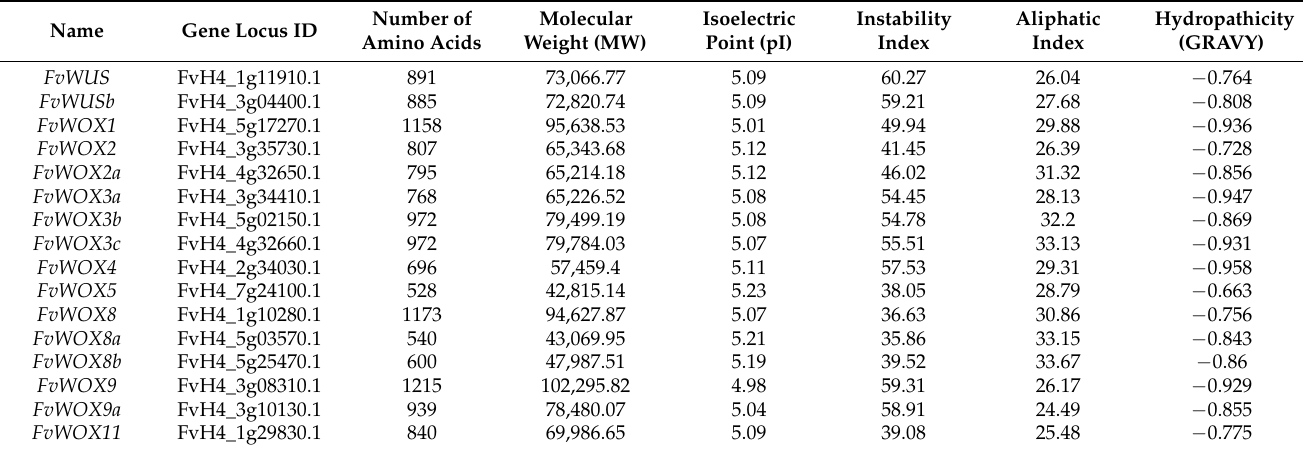
Figure 1. Chromosome localization map of FvWOXs. Yellow vertical bars with various lengths represent the woodland strawberry chromosomes. Short black horizontal lines indicate the position of each FvWOX. Table 1. Summary information of FvWOX